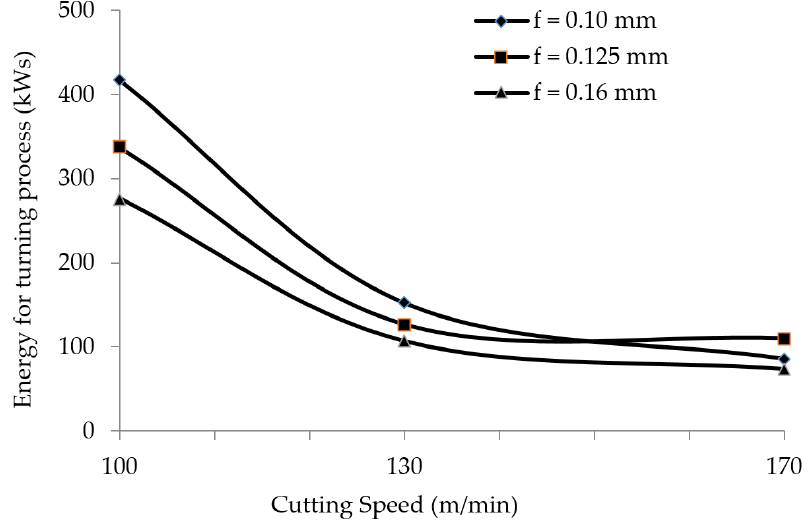
Figure 4. Energy for turning process ( E 2 ) at various cutting speeds and feed.